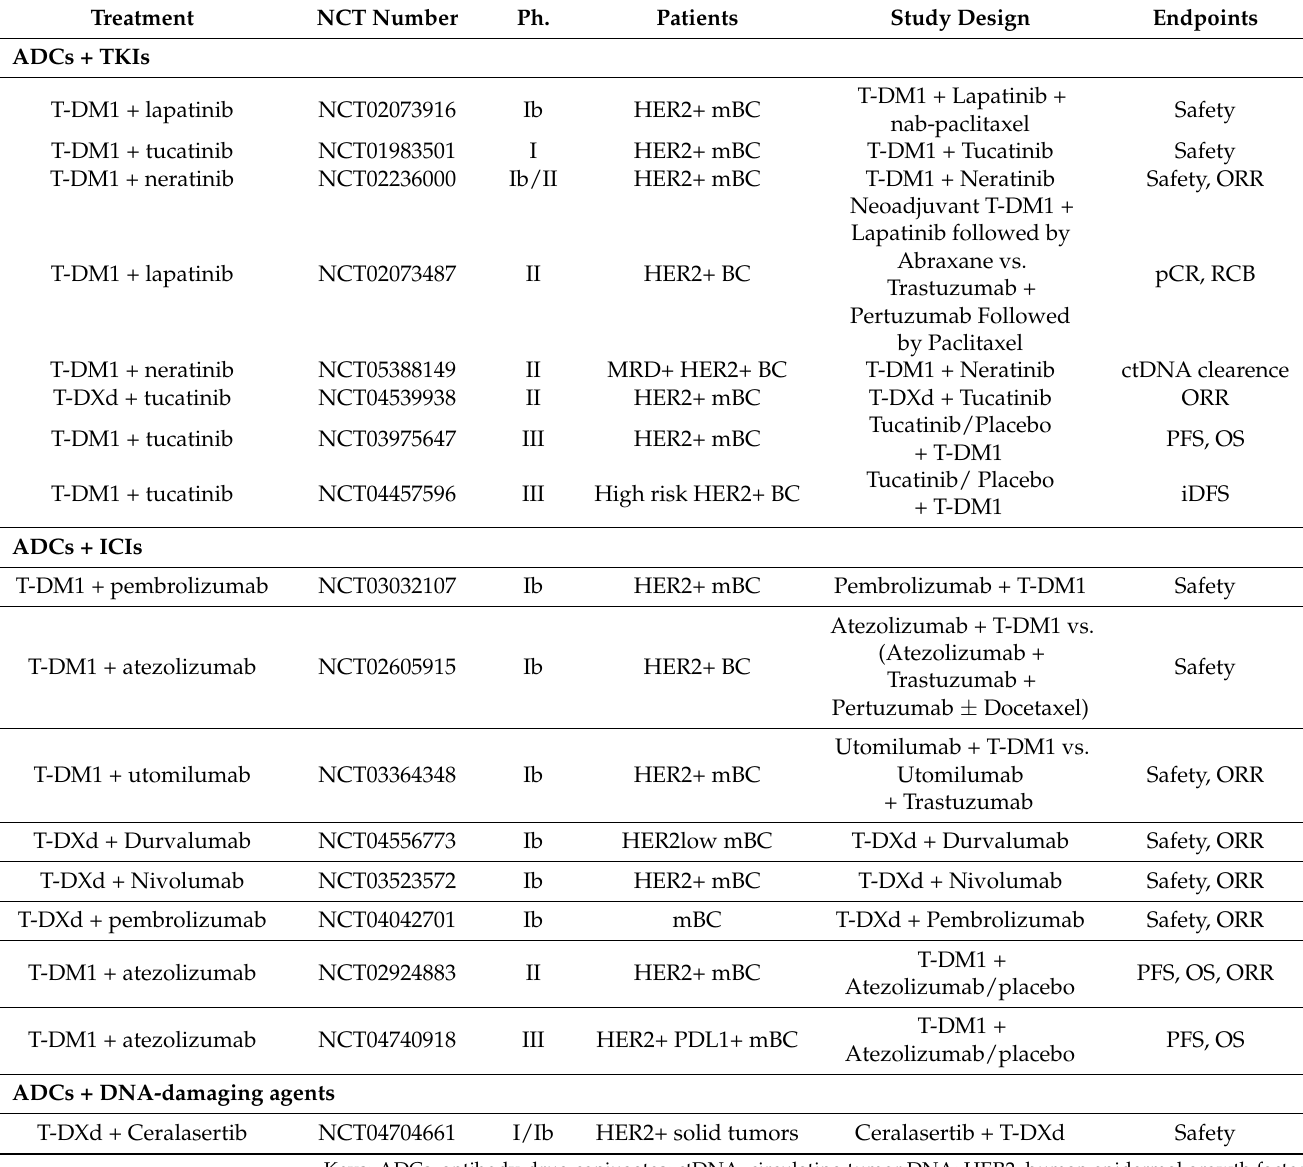
Table 1. Ongoing clinical trials evaluating combinations of antibody-drug conjugates to overcome or prevent resistances in HER2-positive breast